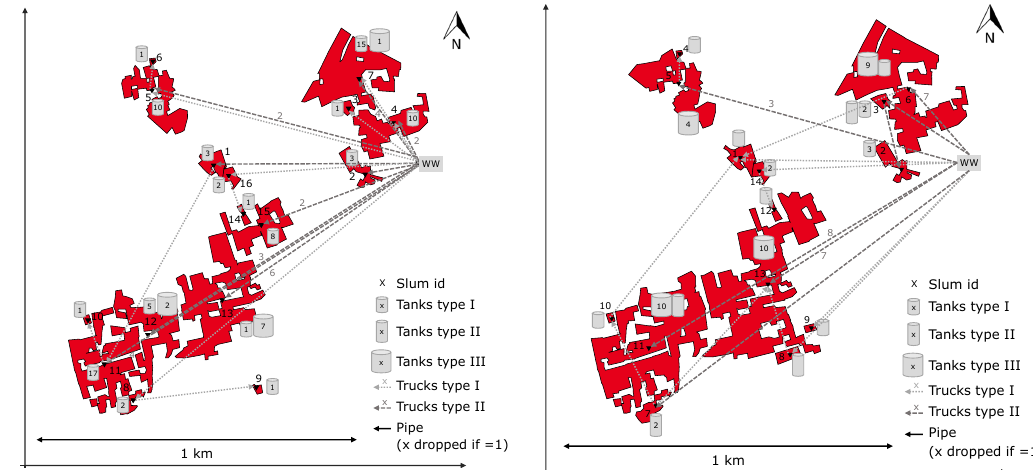
Figure 10. Optimization result for a slum cluster in Dhaka, Bangladesh, in 2006 (left) and in 2010 (right).